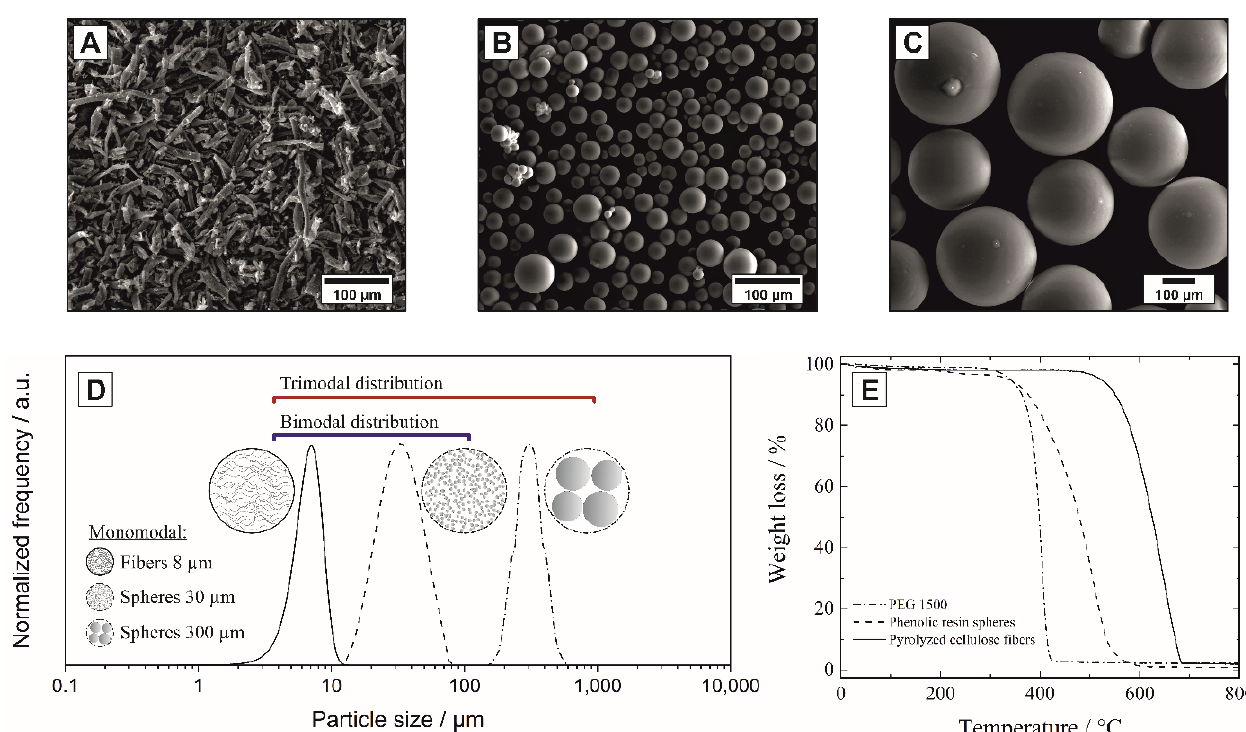
Figure 1. Characteristics of the utilized isotropic and anisotropic sacrificial templates: SEM micrographs ( A – C ) of the pyrolyzed cellulose fibers ( A ), the 30 µm ( B ) and 300 µm phenolic resin spheres ( C ); corresponding monomodal particle size distributions with examples for bi-/trimodal mixtures ( D ) and TGA analysis of the template burn-out in air ( E ).